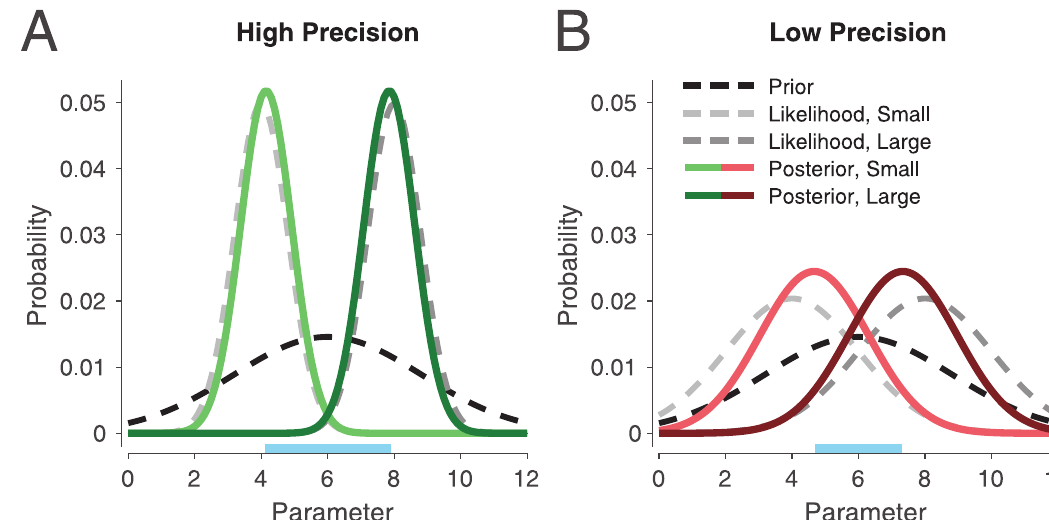
Fig 1. Illustration of Bayesian inference for a task with two parameters of different magnitudes, one small and one large, under either high or low precision. The posterior is the normalized product of the prior and likelihood. (A) When likelihood precision is high compared to prior precision, the posterior will remain close to the likelihood. (B) As the ratio of likelihood precision to prior precision decreases, the posterior migrates toward the prior. Note here that likelihood precision controls the distance between the posterior means (compare lengths of blue segments on the x-axis), a point we return to